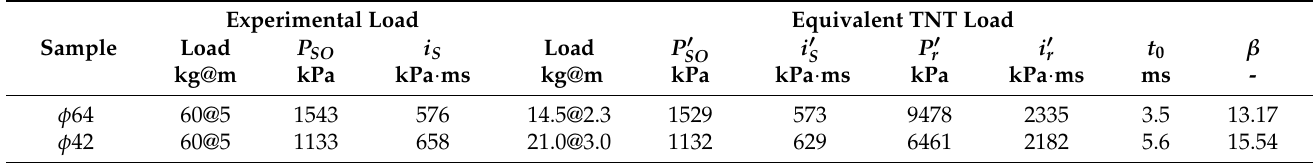
Table 6. Experimental load versus TNT hemispherical equivalent load